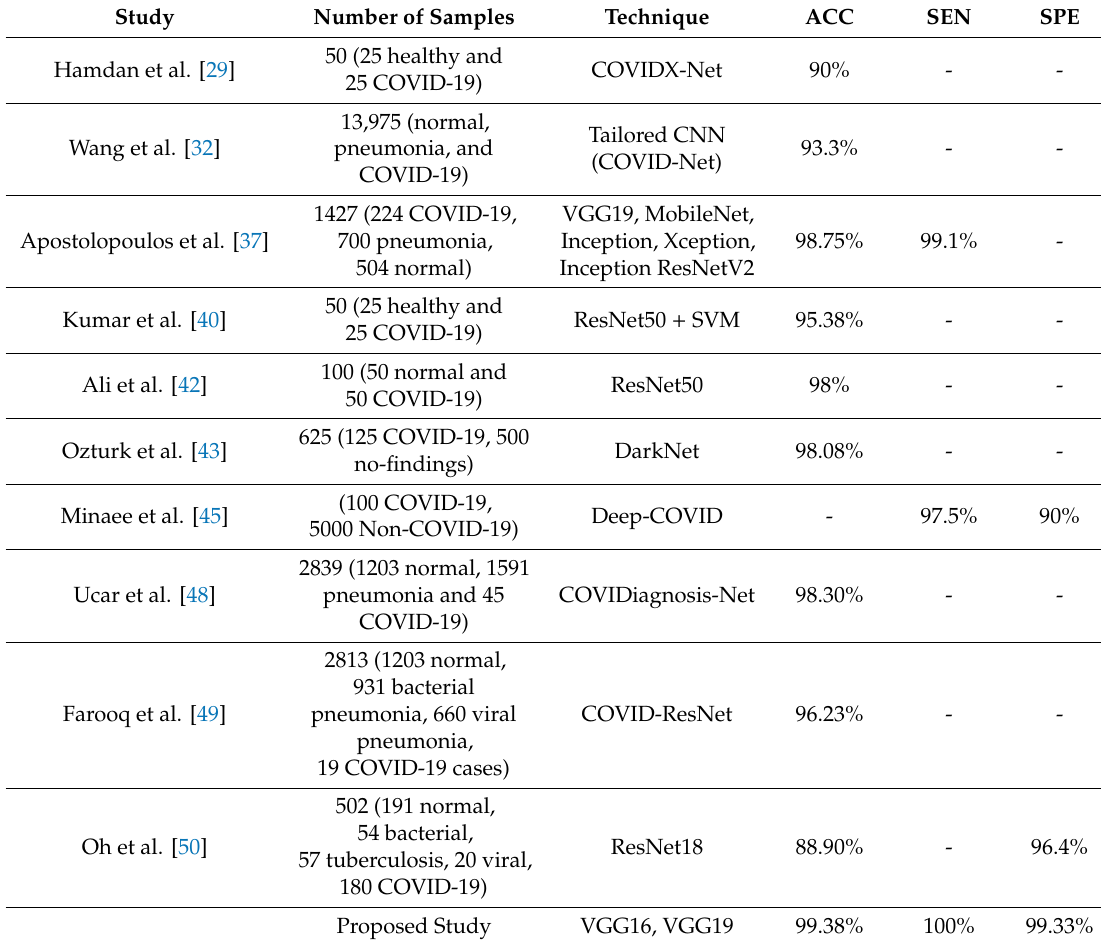
Table 3. Comparison of the proposed method with the benchmark